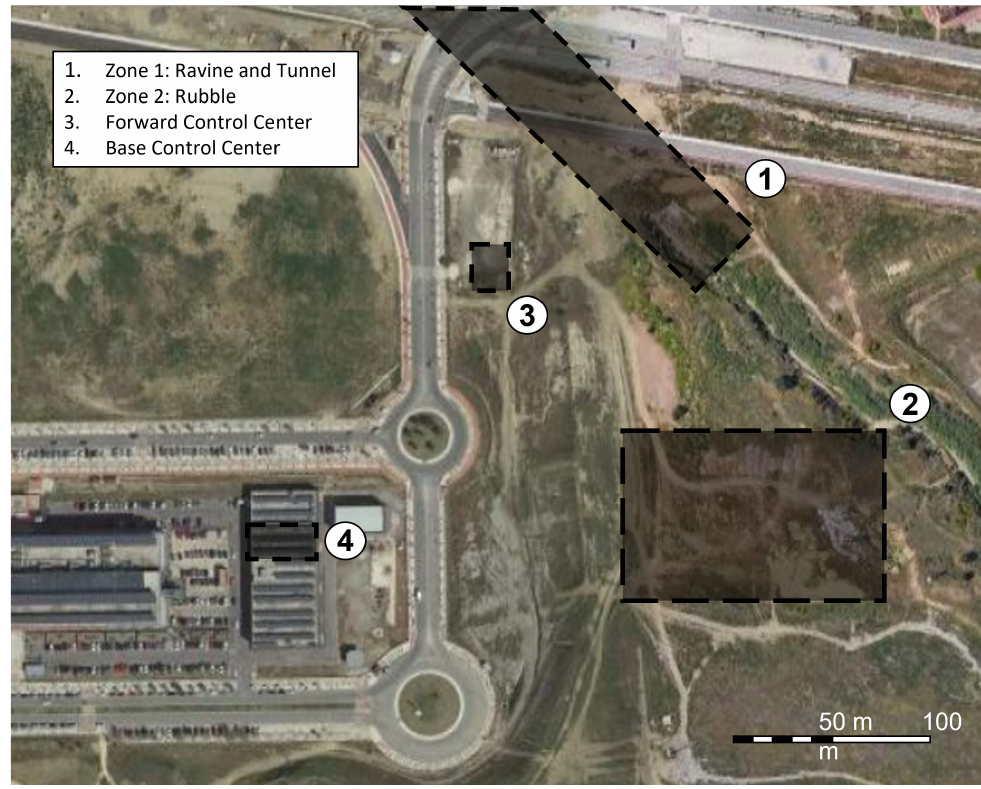
Figure 6. Aerial view [48] of the area of experimentation in new technologies for emergencies (LAENTIEC), where areas indicate relevant